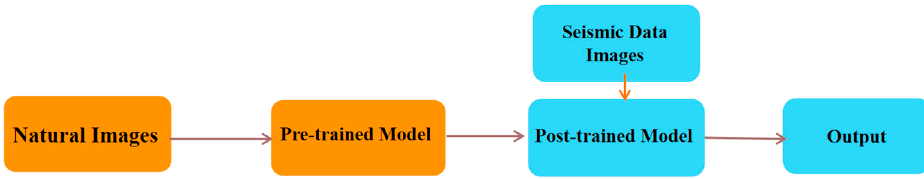
Figure 1. Whole denoising procedure.